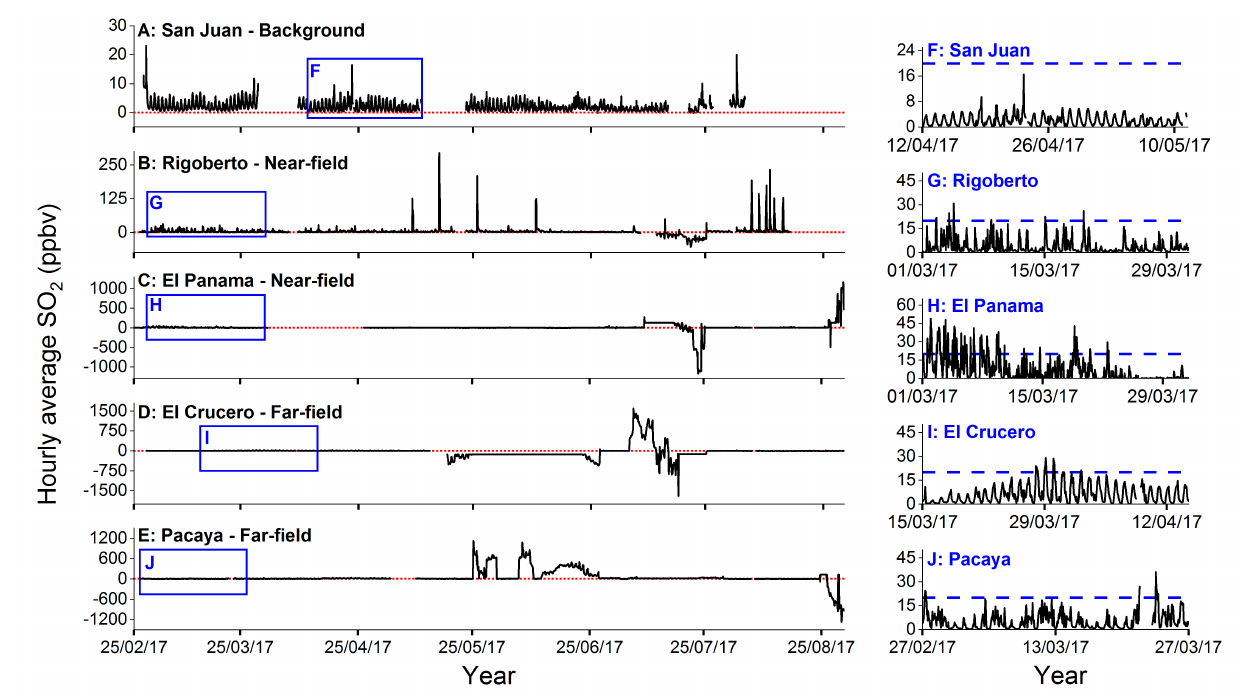
Figure 8: Electrochemical SO measurements from the five AQMesh stations. [A–E]: timeseries of hourly-average 2 electrochemical SO measurements over the six-month experiment period. Periods of missing data result from 2 lack of power due to corroded battery connectors or batteries remaining uncharged after four weeks. Extreme SO 2 peaks and troughs result from failure of the SO electrochemical sensors. Red dashed line indicates 0 ppbv line. 2 Blue outlines indicate time-periods for F–J. [F–J]: 1-month excerpts from the SO timeseries at each AQMesh 2 station, indicating periods of data with no extreme peaks and troughs. Blue dashed line indicates 20 ppbv, the lower limit used for identifying periods of simultaneously enhanced SO to 2